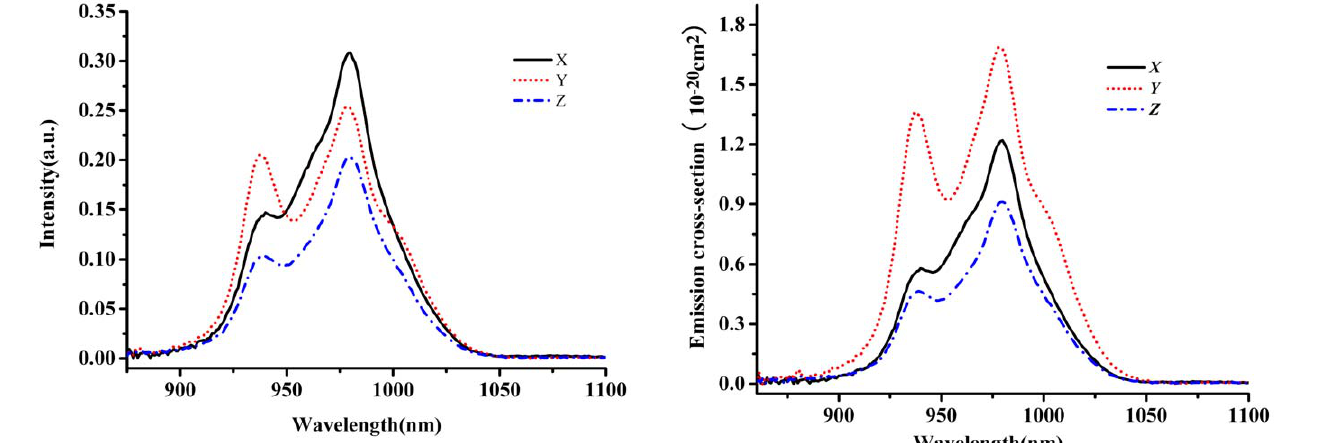
Table 1. Spectral parameters of Yb 3 + :KBaGd(MoO 4 ) 3 and the other Yb 3 + -doped materials.